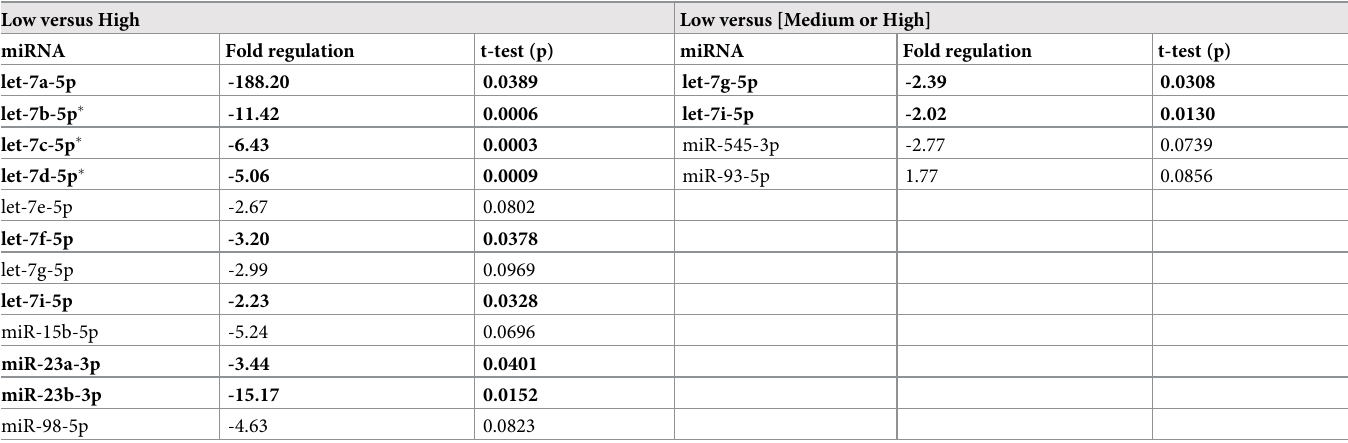
Table 4. Differential expression of miRNA between LV groups displaying low, medium or high